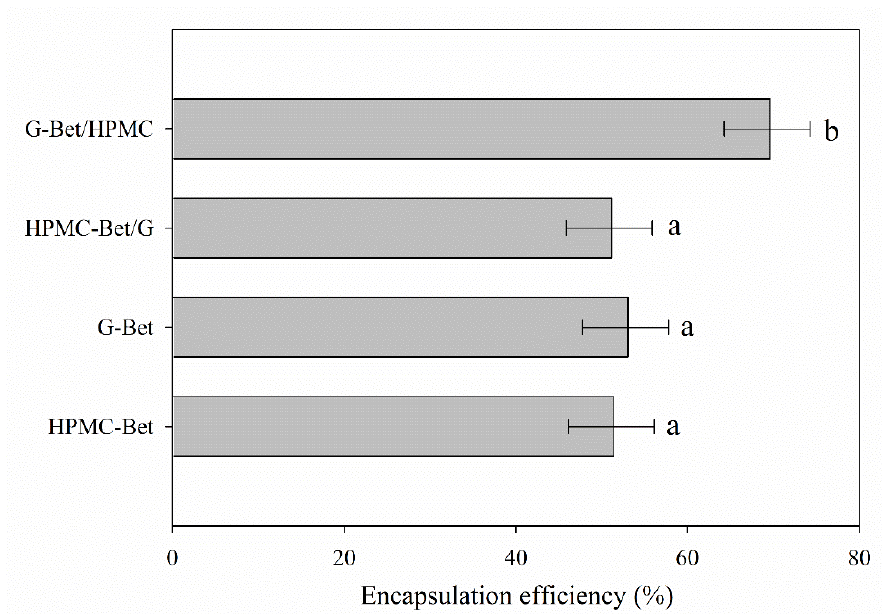
Figure 4. Encapsulation efficiency results of electrosprayed capsules (a and b denote statistically significant differences ( p < 0.05) between EE of developed capsules).